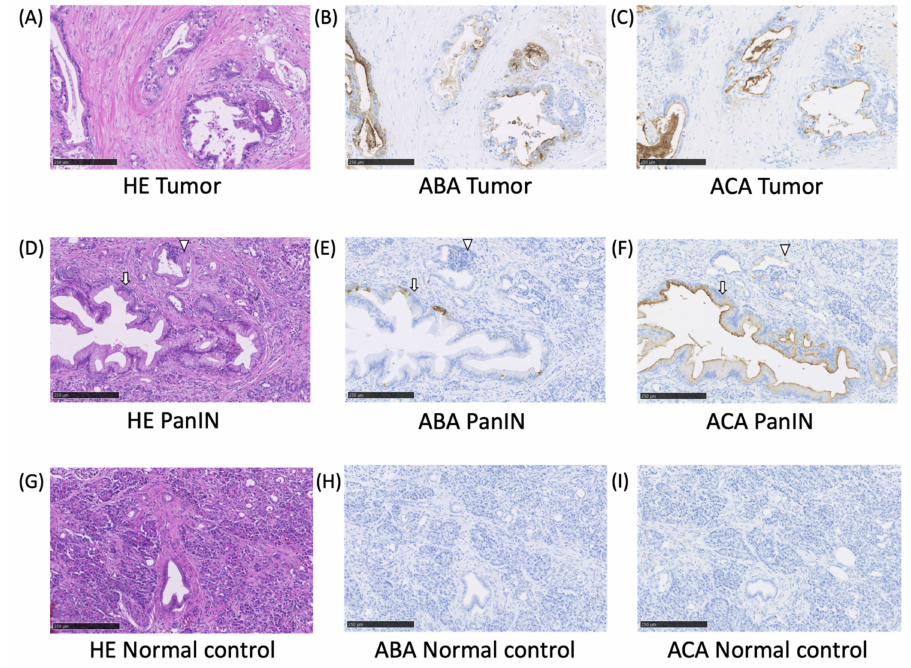
Figure 3. Histochemical staining of PC and PanIN lesions using ABA and ACA. Formalin-fixed para ffi n-embedded tissue sections from a PC patient were stained with the biotinylated ABA and ACA. The upper panel shows the invasive tumor ( A – C ), and the lower panel shows PanIN ( D – F ), and the normal pancreatic tissue ( G – I ). Hematoxylin-eosin: A, D, and G, ABA: B, E, and H, ACA: C, F, and I. PanIN and acinar-to-ductal metaplasia are indicated with an arrow and an arrowhead, respectively. The scale bars show 250 µ